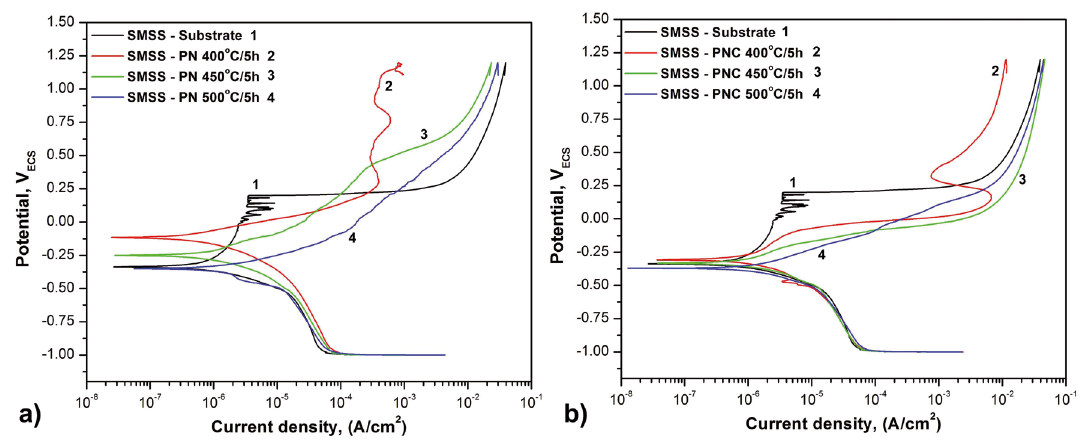
Figure 3. Potentiodynamic polarization curves of plasma (a) nitrided and (b) nitrocarburised SMSS samples in 3.5% NaCl